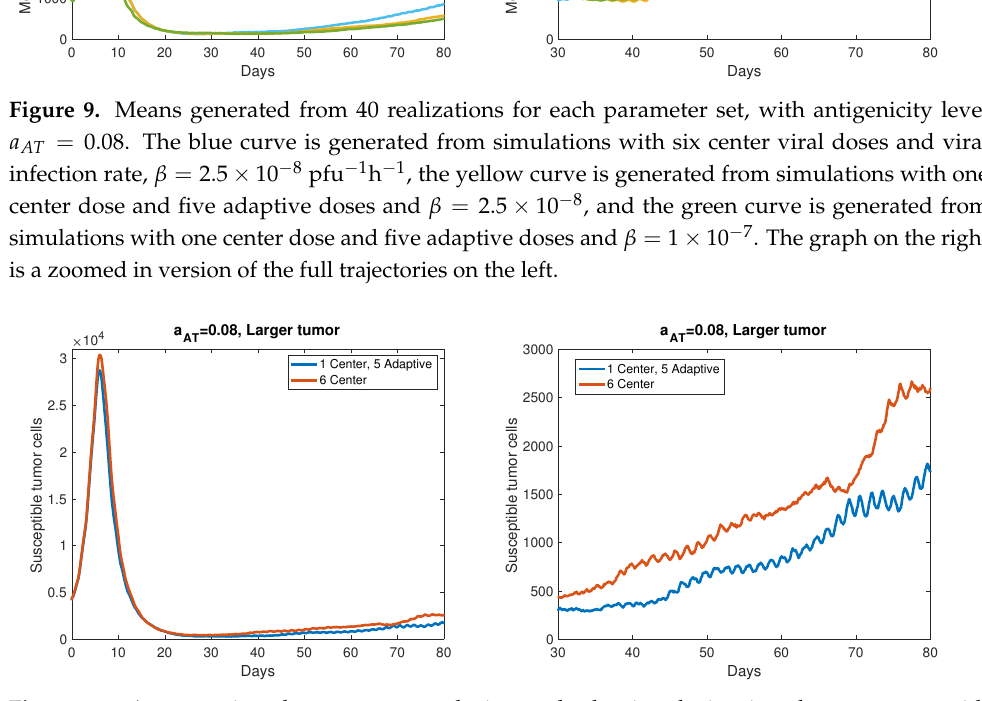
Figure 10. A comparison between center dosing and adaptive dosing in a larger tumor, with a AT = 0.08. The single simulation starts with a tumor radius of 10 tumor cells, or 4169 total cells, about 4 times the initial susceptible tumor population that we use in our baseline